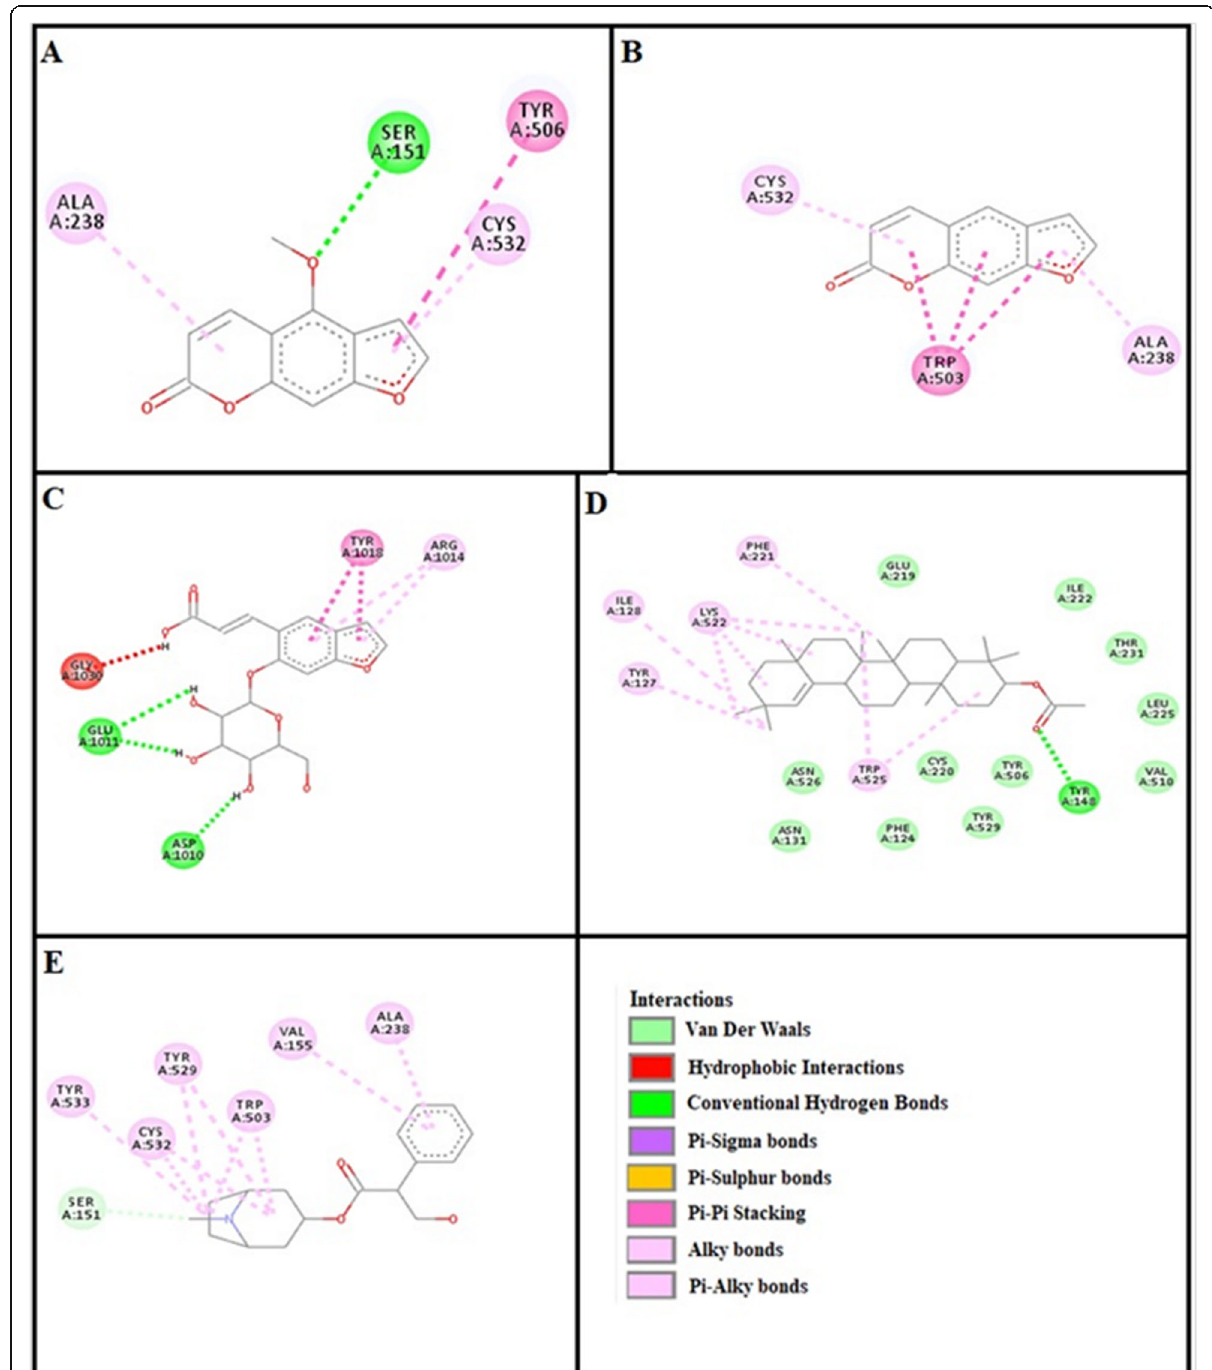
Fig. 8 a , b , c , d and ( e ) represents interactions of bergapten, psoralene, psoralenoside, germanicol acetate and atropine against target: musranic M 3 receptor respectively, evaluated through Biovia Discovery Studio